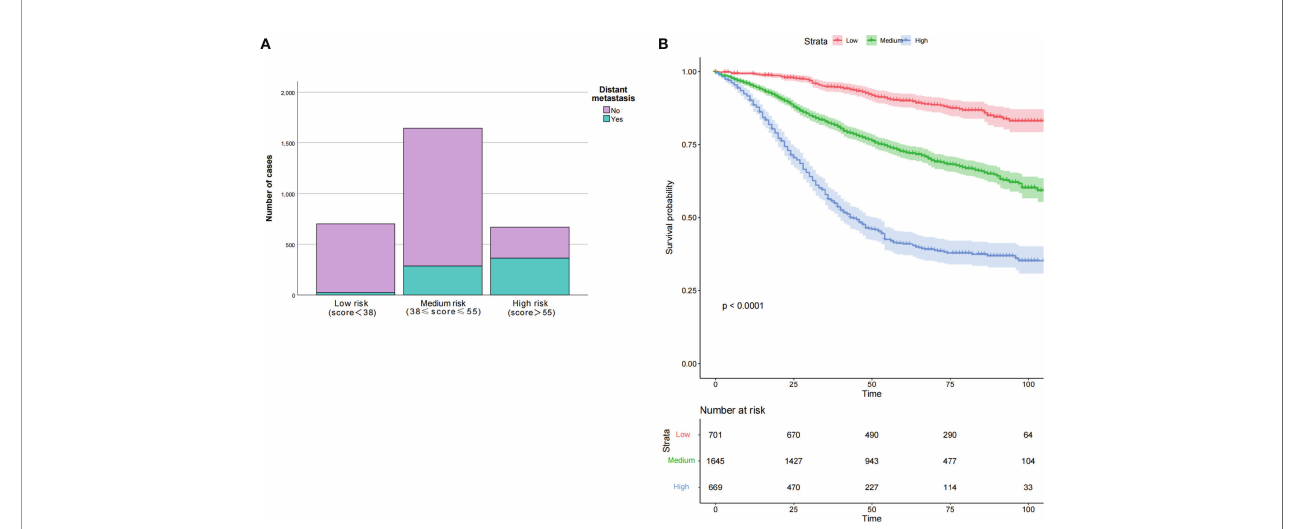
FIGURE 6 | Clinical effects of the risk score in our nomogram in training set. Based on the interquartile range of risk score, our nomogram divided participants into three subgroups. The number of distant metastasis in each subgroup was present in (A) , both p < 0.001. The OS was also evaluated among the different risk subgroups with p < 0.0001 (B) . OS, overall